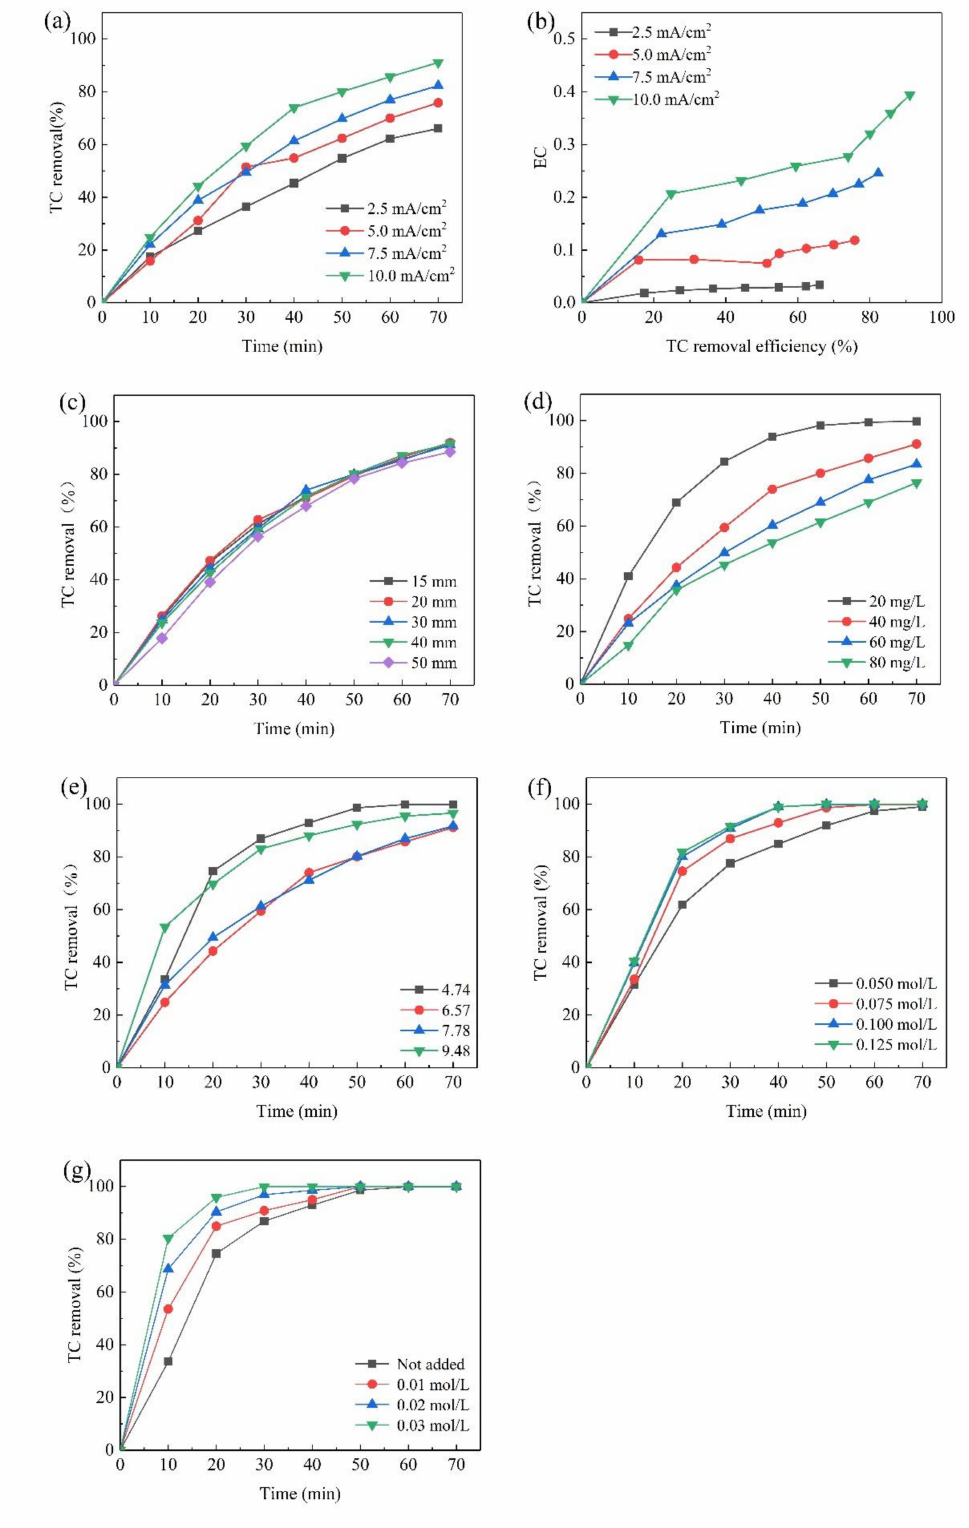
Figure 4. Effects of current density ( a , b ), electrode spacing ( c ), initial concentration ( d ), solution pH ( e ), electrolyte concentration ( f ) and Cl − concentration ( g ) on TC